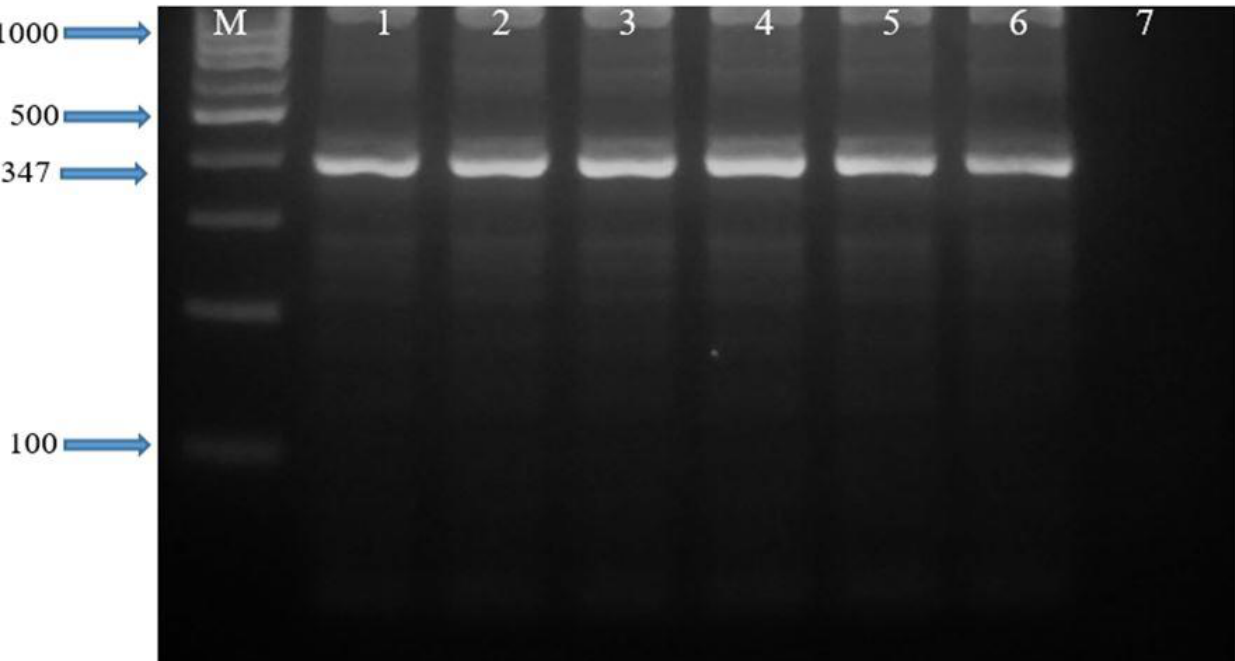
Fig.2: Stx1 gene product in E. coli O157:H7 isolates (347 bp).